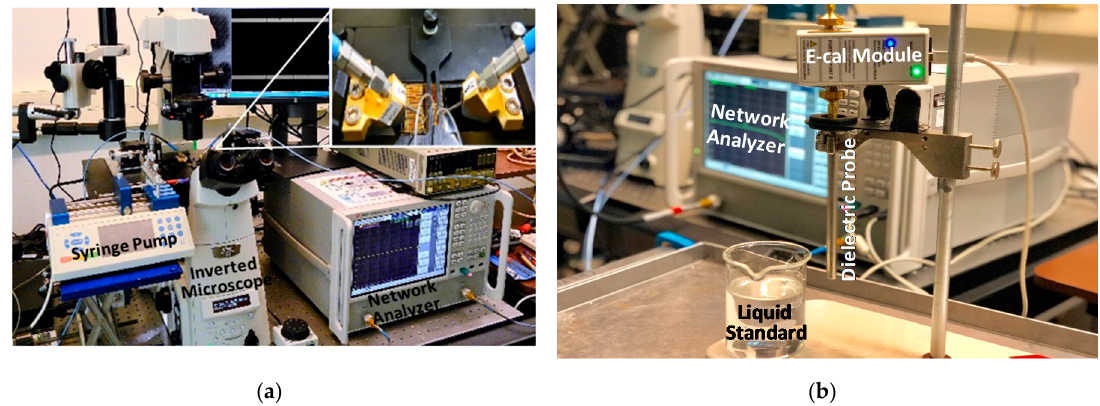
Figure 3. Photographs of measurement setup for ( a ) S parameters of the test chip and ( b ) permittivity of the liquid standard using the same vector network analyzer.